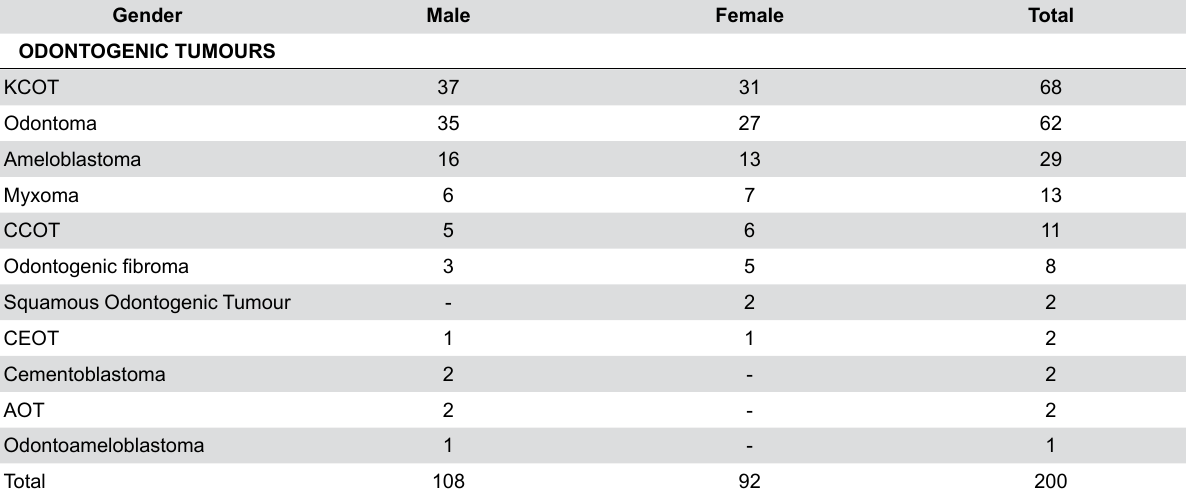
Table 2- Distribution of OTs according to histology and gender in a Brazilian Oral Pathology